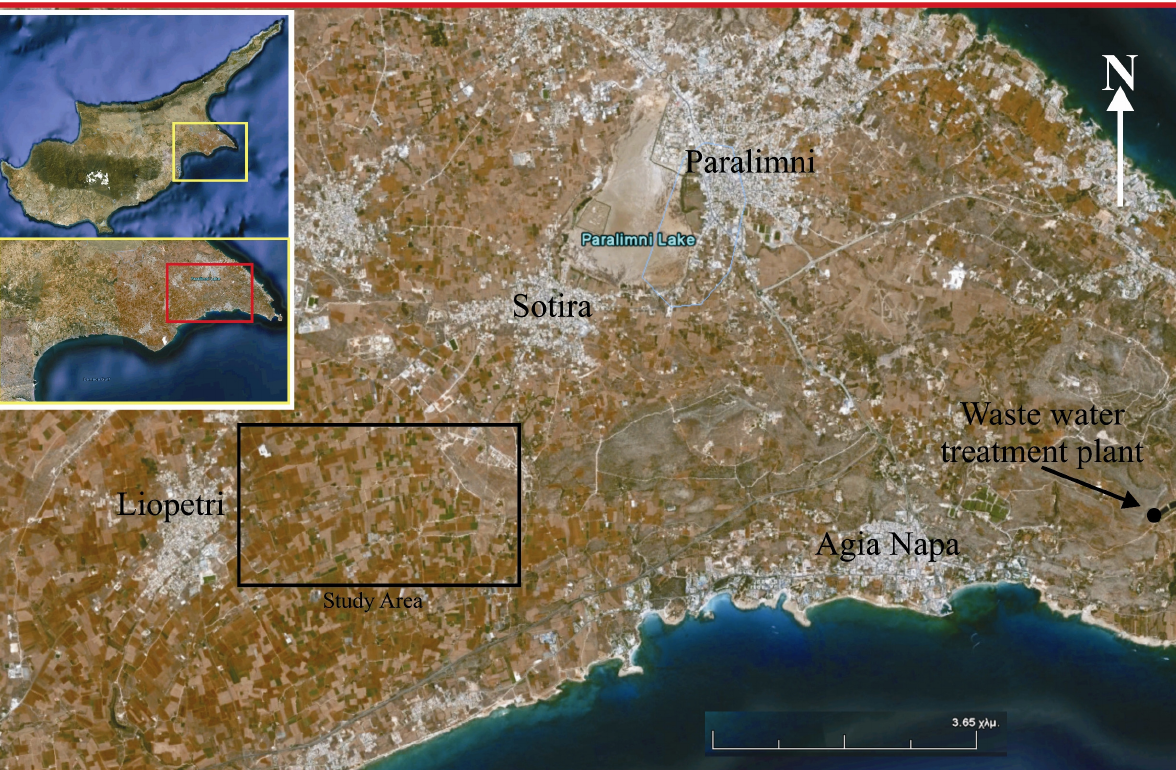
Figure 2. Location of the study area (Adapted from Google Earth with